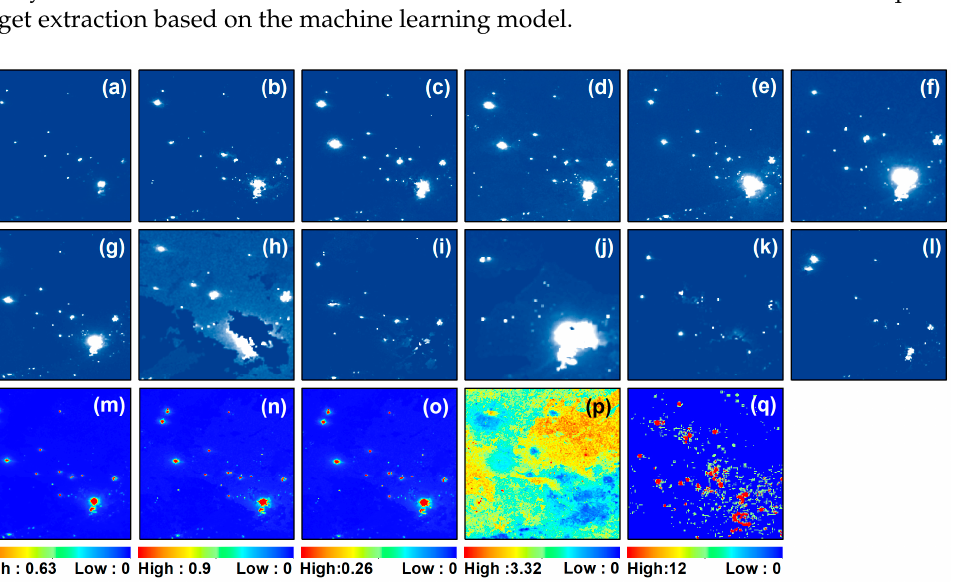
Figure 3. Multi-features construction: ( a – l ) are the normalization results of the time-series images; ( m ) is the image of the mean statistics; ( n ) is the image of the maximum statistics; ( o ) is the image of the standard deviation statistics; ( p ) is the image of the coefficient of variation statistics; and ( q ) is the image of the occurrence frequency statistics.